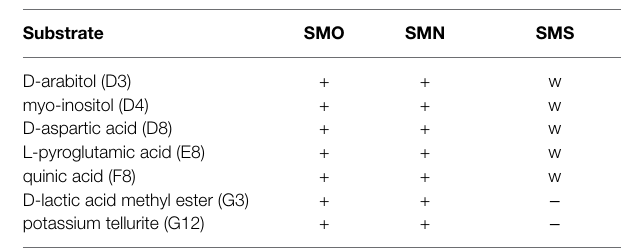
significant ( p = 0.0066, p = 0.0057; Figure 5 ).